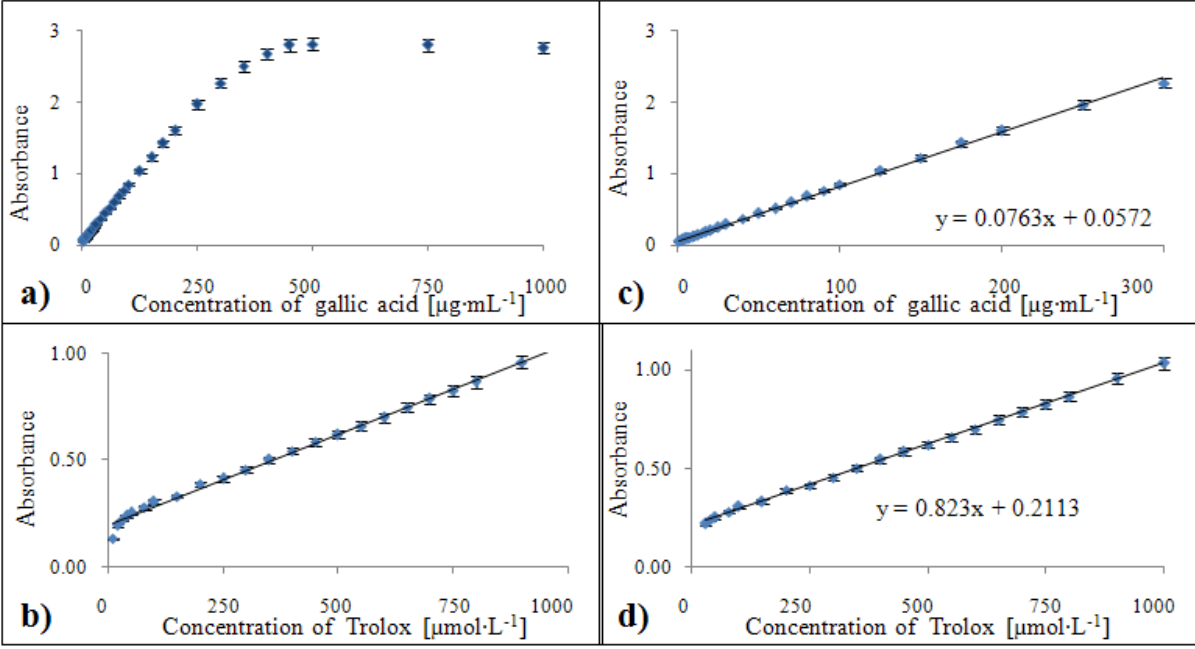
Figure 9. Dependences of absorbance of colour product on concentration of gallic acid (a) and Trolox ® (b) . Calibration curves for FRAP method related to equivalent of gallic acid (c) and Trolox ® (d) expressed in units of absorbance.